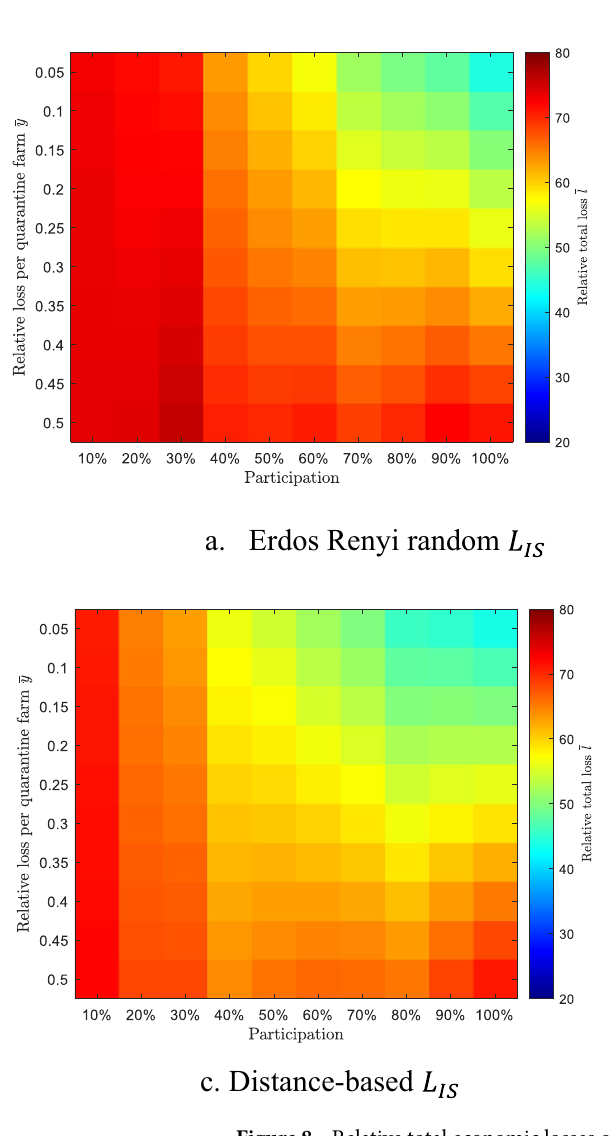
Figure 8. Relative total economic losses on networks with different L IS (highest-degree